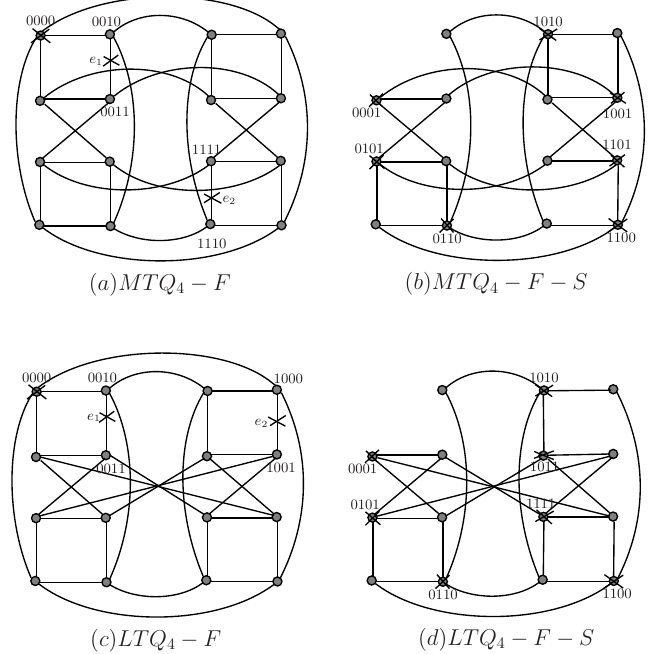
Fig.3. Illustration about the proof of Lemma